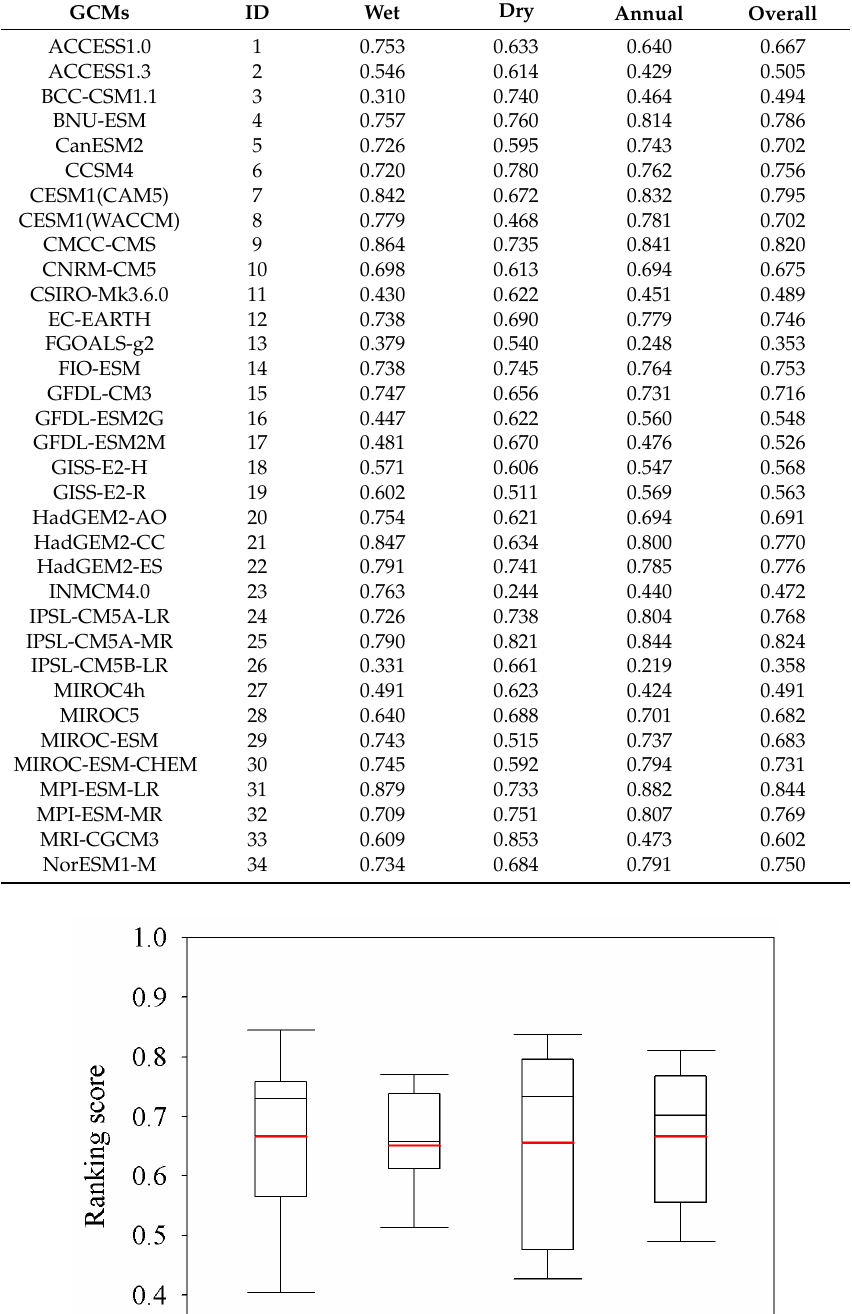
Table 2. Ranking scores of the GCMs’ performances for the wet season, dry season, annual time, and overall results over the LMB.